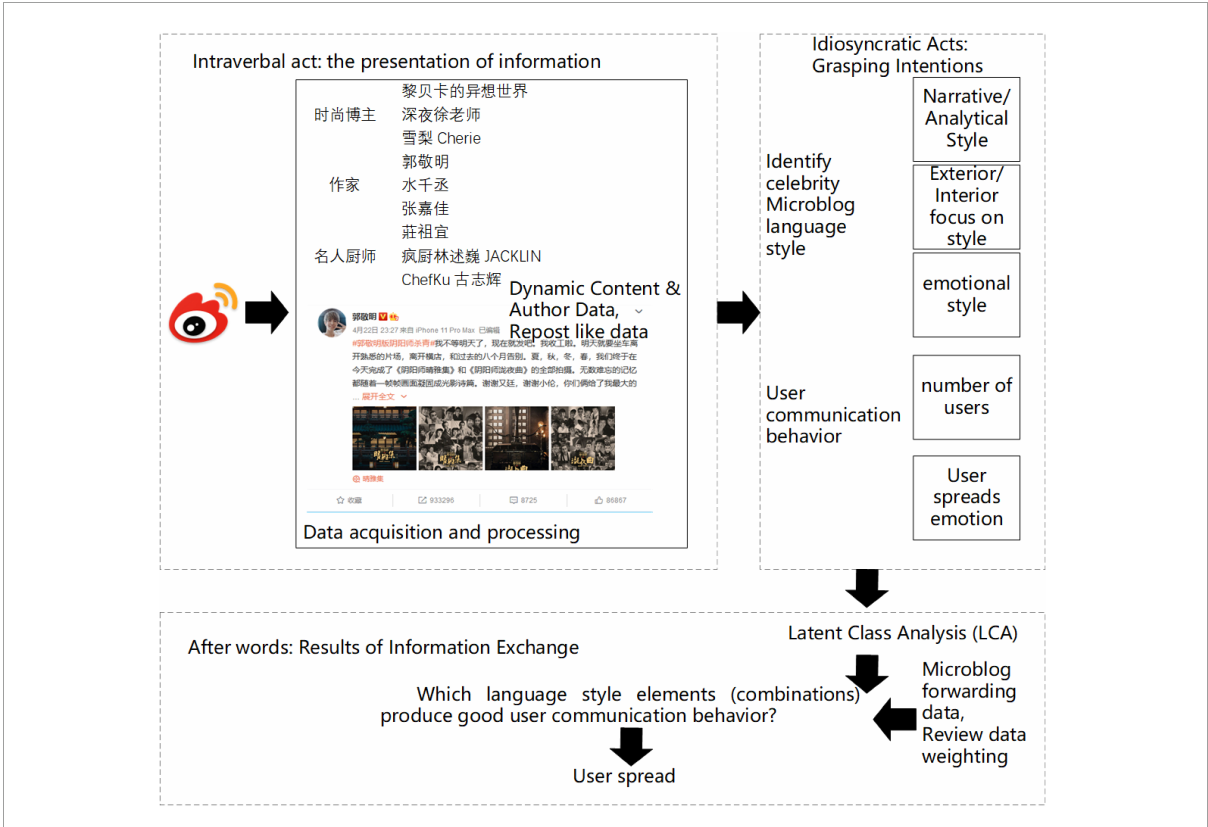
FIGURE1 A model of celebrity opinion dissemination based on speech act